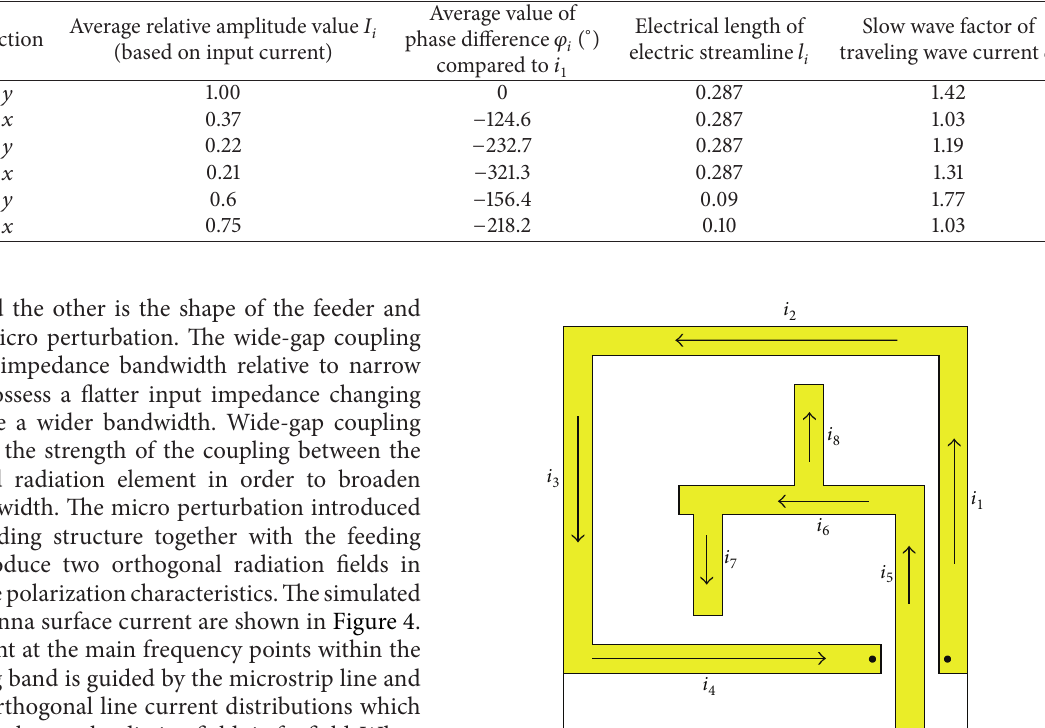
Table 1: Surface current ( 𝑖 1 ∼𝑖 6 ) at 1.228 GHz.